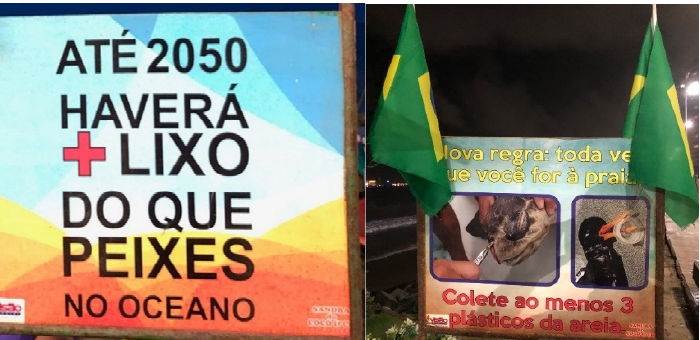
Figure 2. The banners at the Fortaleza (Cear á , Brazil) beach, made by aware citizens. Left photo: “By 2050, there will be + waste in the ocean than fishes”; Right photo: “New rule: every time you go to the beach, collect at least 3 plastics from the sand”. Photos taken on 6 March 2019 by a co-author of this work, R. M.